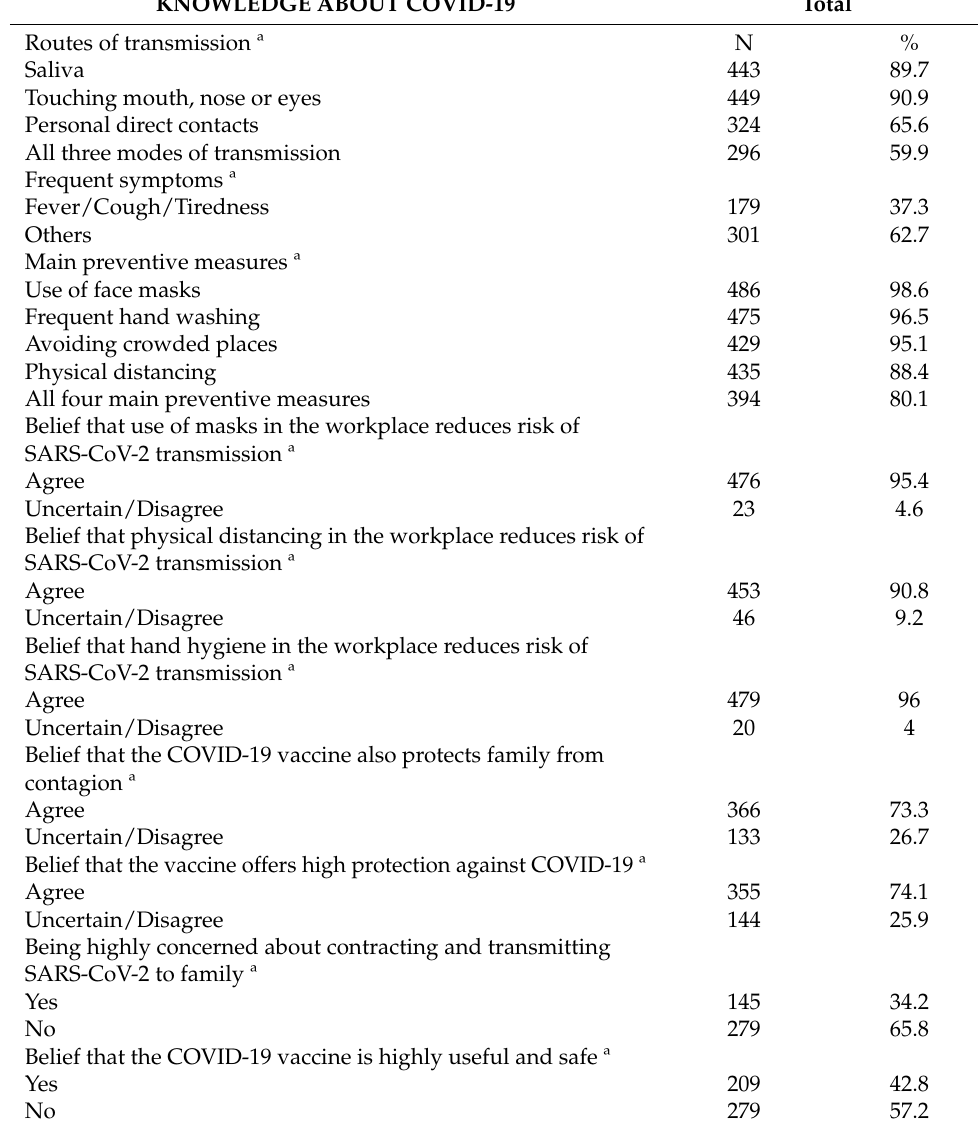
Table 3. Knowledge and attitudes about COVID-19: transmission, main symptoms and preventive measures (N =